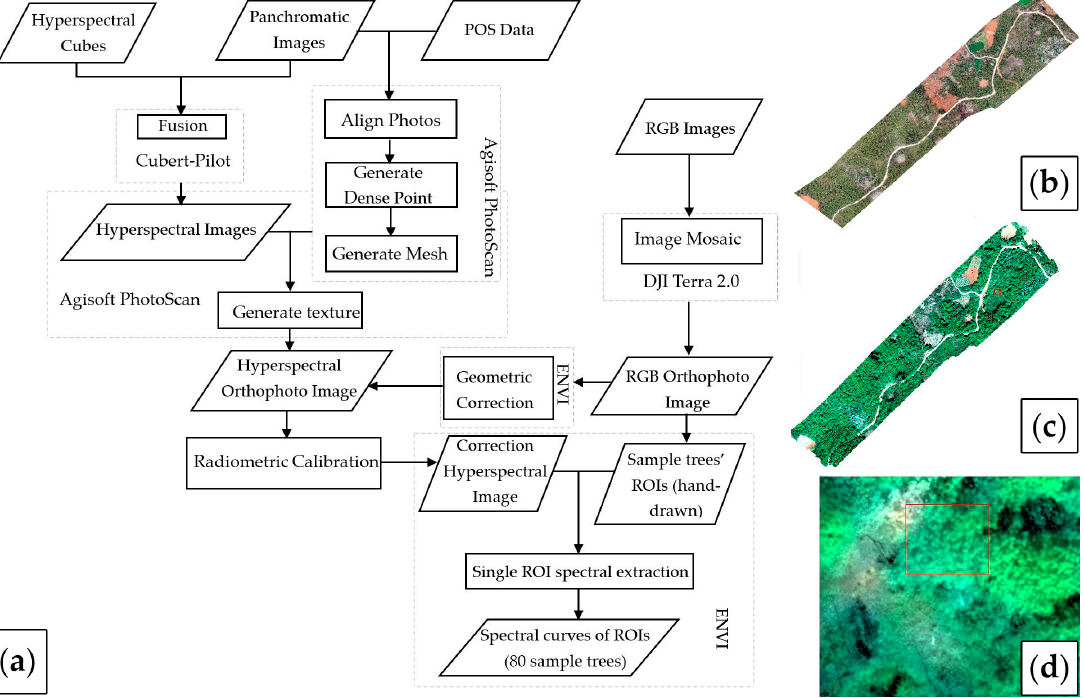
Figure 3. Preprocessing flow. ( a ) Image preprocessing flow. ( b ) RGB orthophoto image. ( c ) Correction hyperspectral image. ( d ) A local magnification of the hyperspectral image. Position and orientation system (POS); Red-Green-Blue (RGB); Region of interest (ROI).